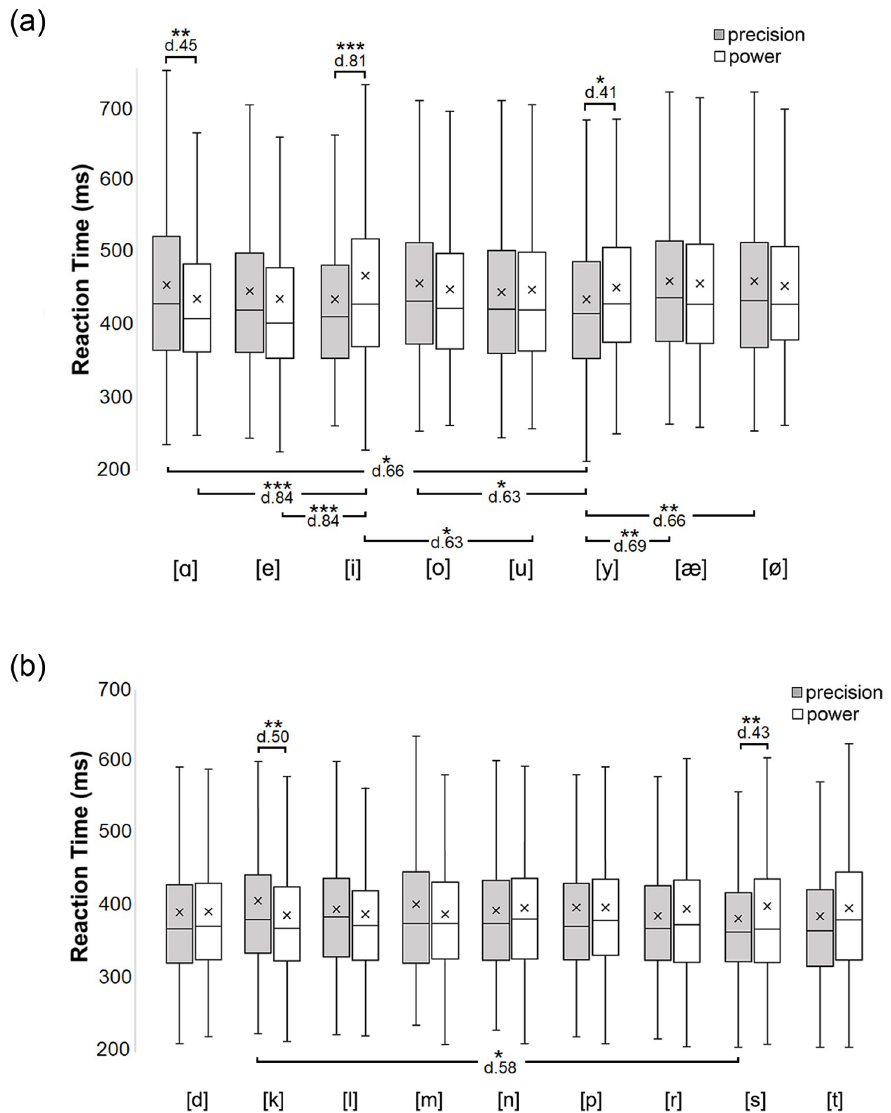
Fig 2. Box-plot of reaction times (ms = millisecond) for Experiment 2 (horizontal line inside the box = median; cross inside the box = mean; box = 25–75%; whiskers = scores outside the middle 50%). It shows the distributions of RT (reaction time) values as a function of Speech unit and Grip. Asterisks indicate statistically significant differences ( ��� p < .001, �� p < .01, � p < .05). The upper box-plots (Fig 2a) present the results for vowels and lower box-plots (Fig 2b) present results for